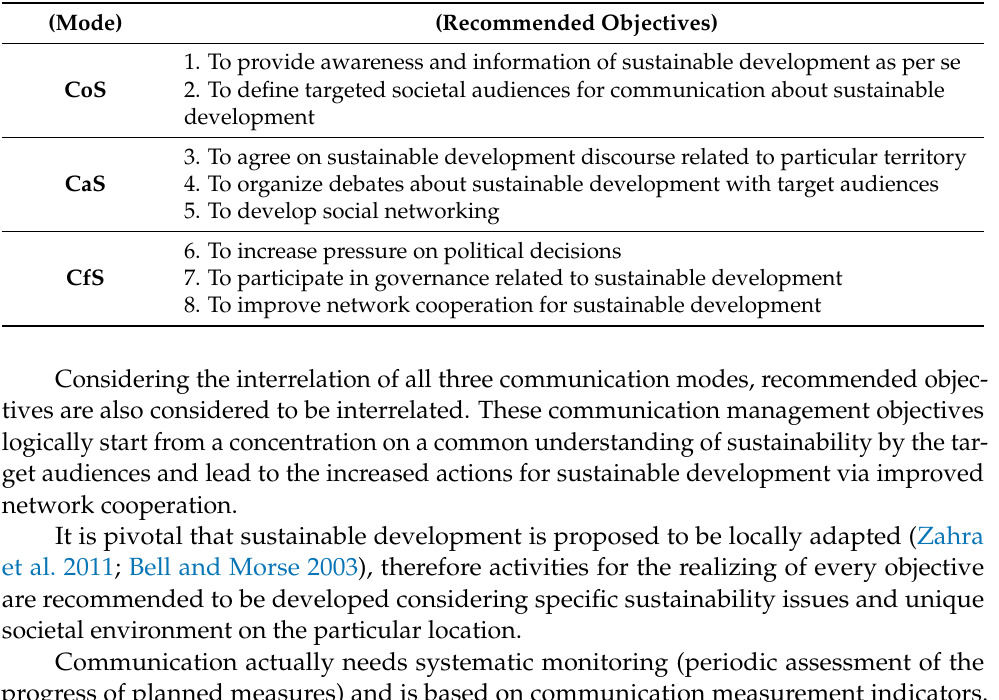
Table 1. Objectives for effective communication.